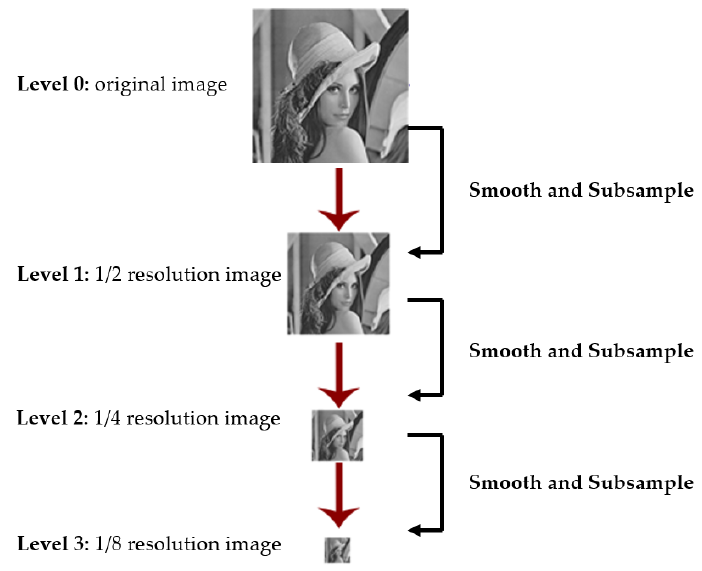
Figure 1. Representation of an image pyramid with four levels.